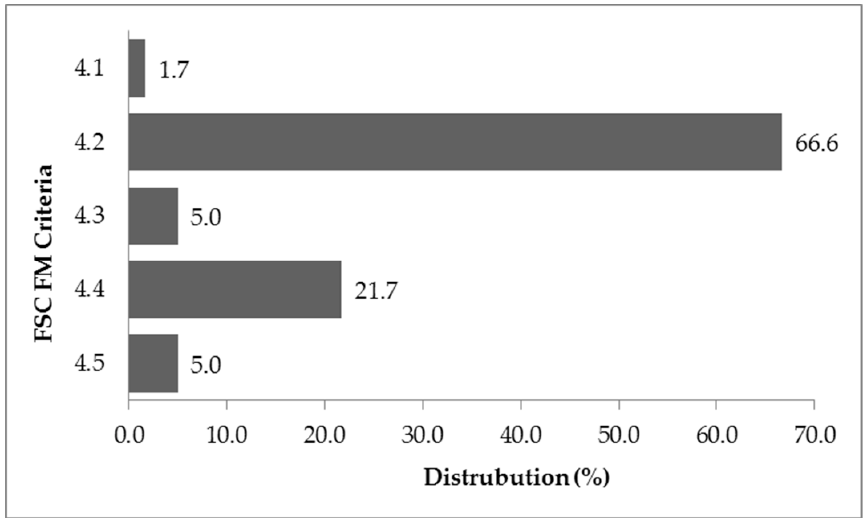
Figure 2. The distribution of criteria related to Principle 4.